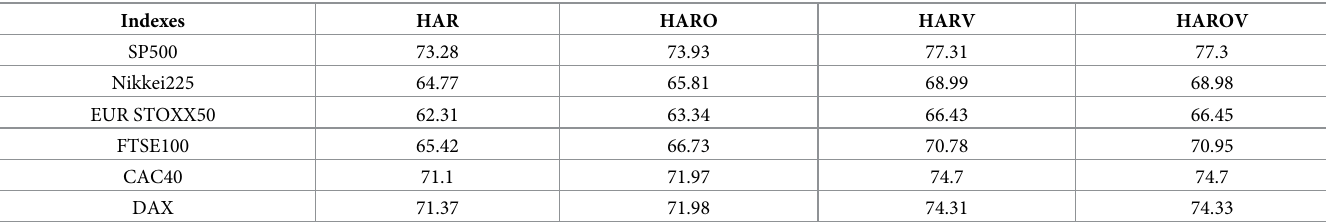
Table 2. Adjusted R-square of HAR, HARO, HARV and HAROV (in percentage terms).